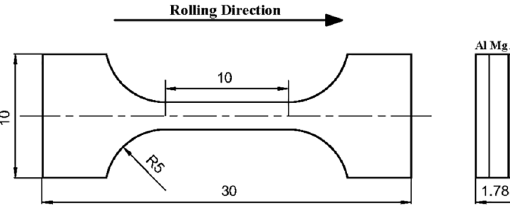
Figure 3. Schematic representation of tensile test